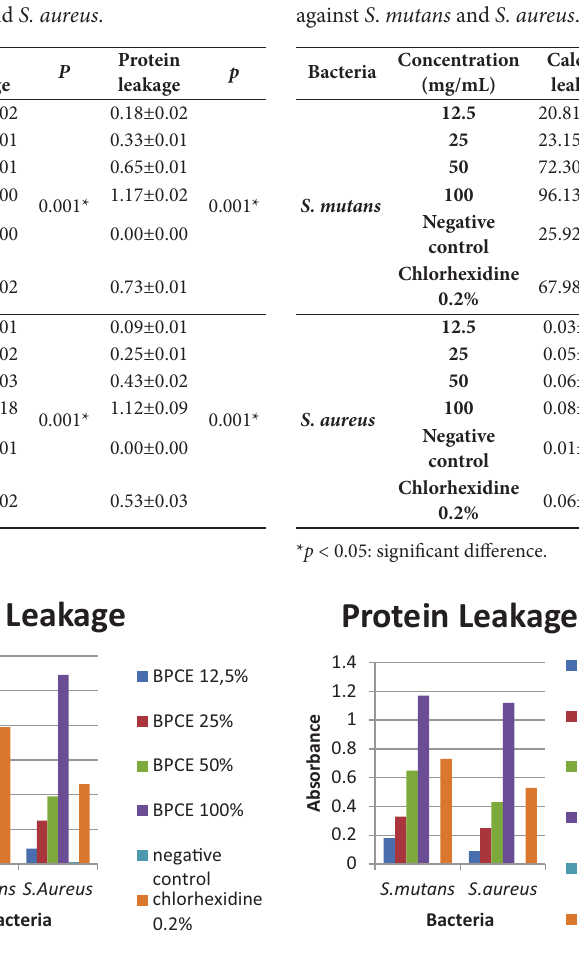
Figure 3. The effect of BPCE on membrane intracellular (DNA and protein) leakage from S. mutans and S. aureus at different con- centrations. Each colour represents the absorbance from different concentrations of BPCE (mg/mL) in each bacteria.